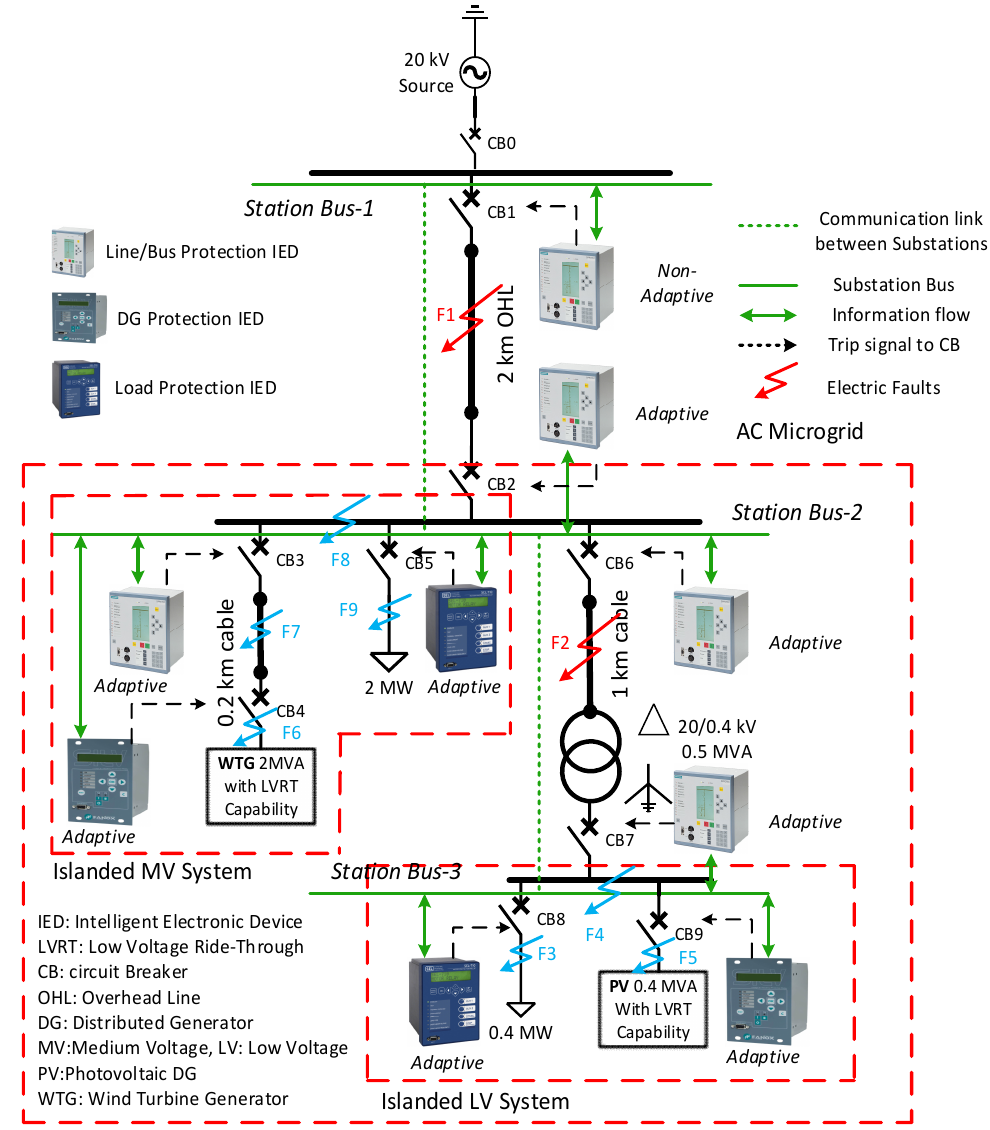
Figure 2. The radial MV/LV AC microgrid model for adaptive protection study.